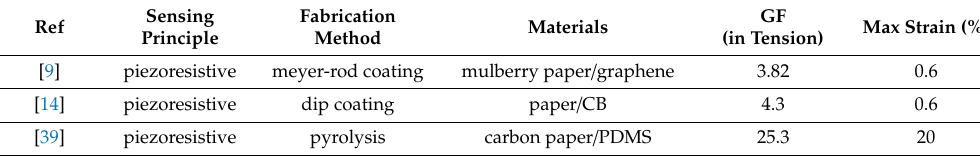
Table 1. Comparison of piezoresistive sensors in the